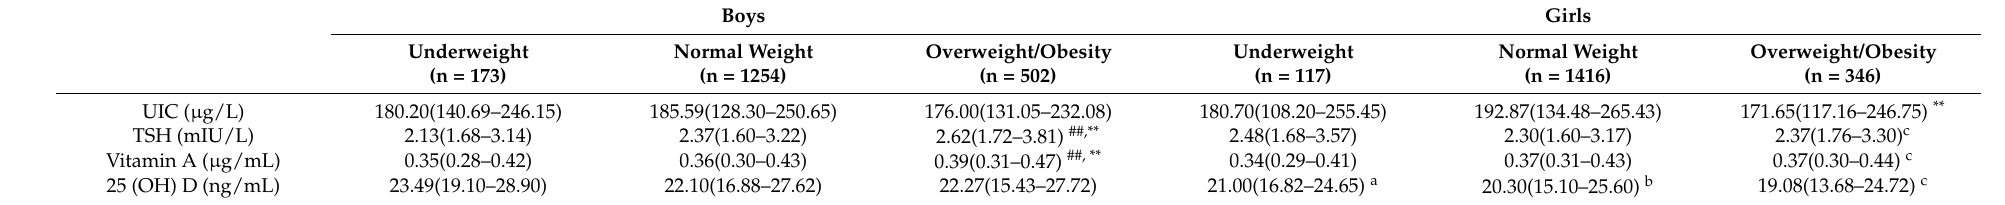
Table 4. Characteristics of schoolchildren with underweight, normal weight, and overweight/obesity (median, P 25 –P 75